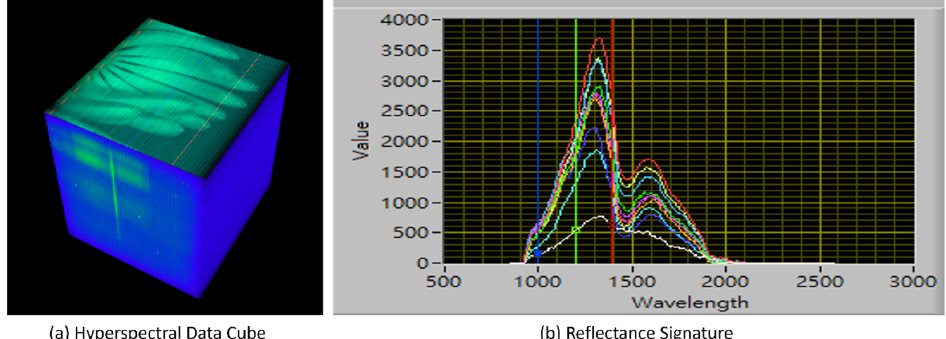
Figure 3. Hyperspectral Profile displayed in ( a ) hypercube data and ( b ) reflectance signature.